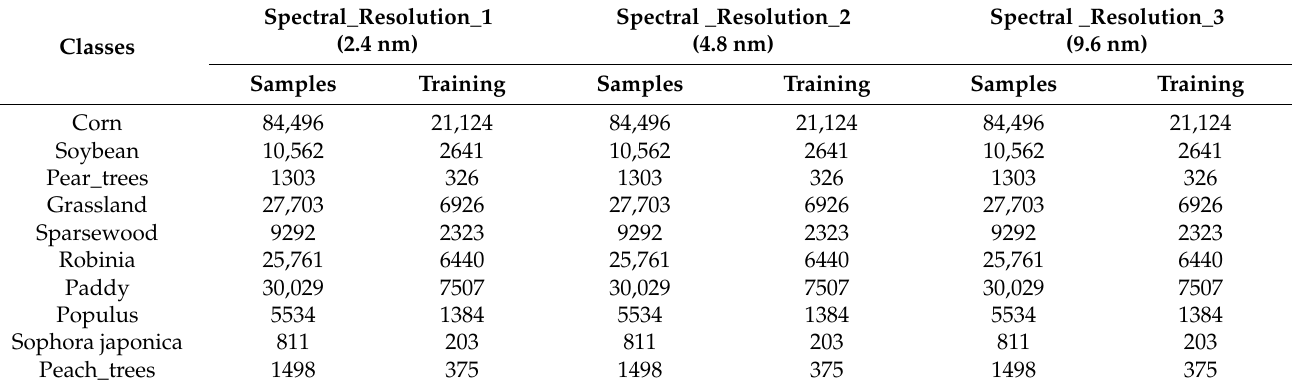
Figure 14. Comparison of the average accuracies of SVM classification on Spectral_resolution_1, Spectral_resolution_2, and Spectral_resolution_3 after using different DR methods. Table 8. Samples and training samples used in the Xiong’an with different spectral resolutions.